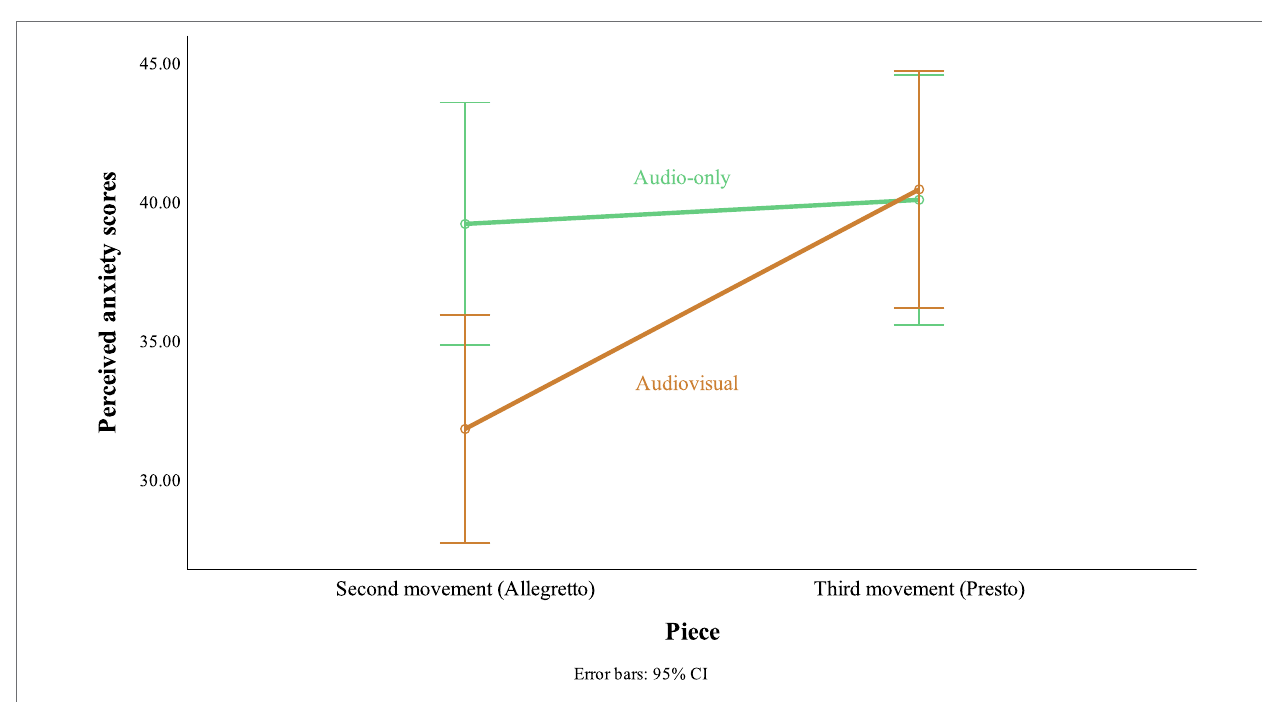
FIGURE 2 | Interaction effect of piece performed and stimulus